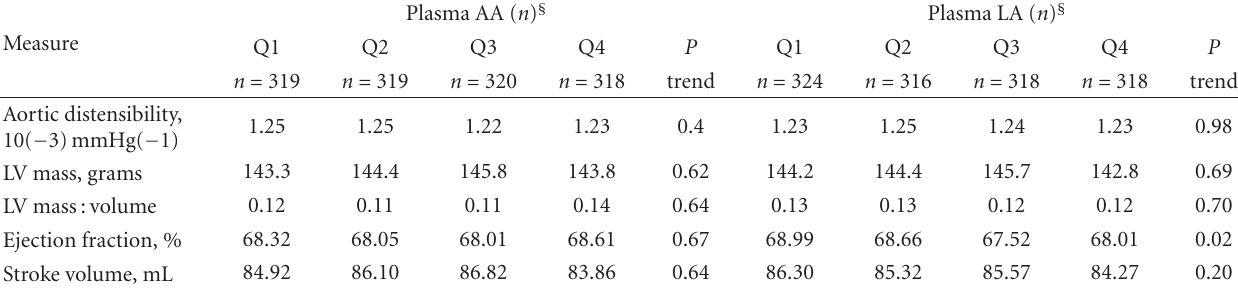
Table 2: Relation between plasma phospholipid omega-6 fatty acid levels and measures of cardiac structure and function. ‡ , ∗